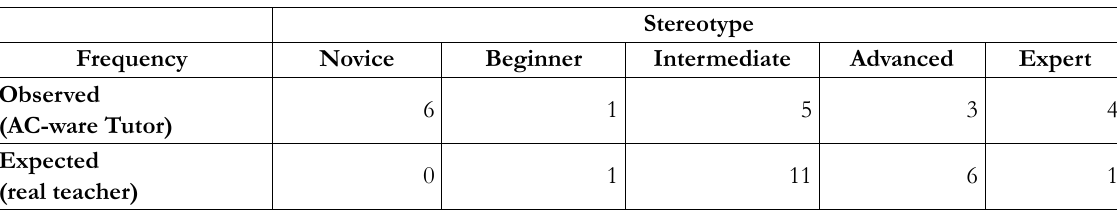
Table 2. Observed and expected frequencies of